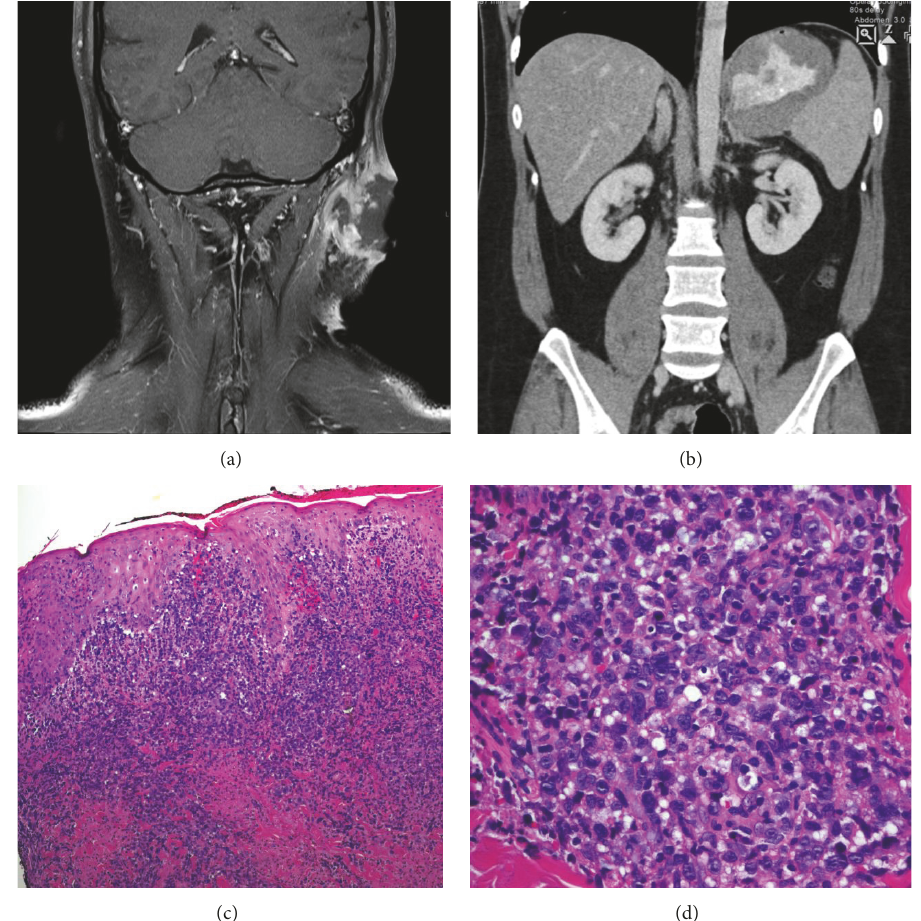
Figure 2: Affection of facial muscles and internal organs. (a) MR of the neck showing a large ulcerating tumor on the left side with infiltration into nearby muscles. (b) CT of the abdomen showing massive thickening of the ventricular wall due to lymphoma with infiltration also into the spleen and left adrenal gland. (c, d) Skin biopsy from the neck lesion showing sheets of lymphoid cells throughout dermis, with large pale gray nuclei with prominent nucleoli (H&E, 100x and 400x, resp.). On immunohistochemistry, the cells were positive for CD20, Pax5, Bcl-2, MUM1, and EBERISH and negative for CD3, CD4, CD5, CD8, CD30, CD10, Bcl-6, and cyclin D1. Ki-67 showed a proliferative fraction of 70–80% of tumor cells. The lesion was classified as diffuse large B-cell